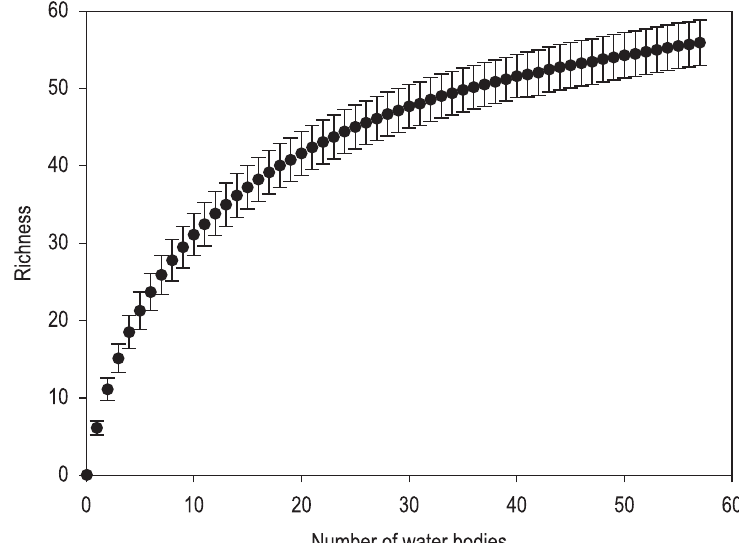
Figure 1. Rarefaction analysis based on the number of water bodies sampled in the Federal District,